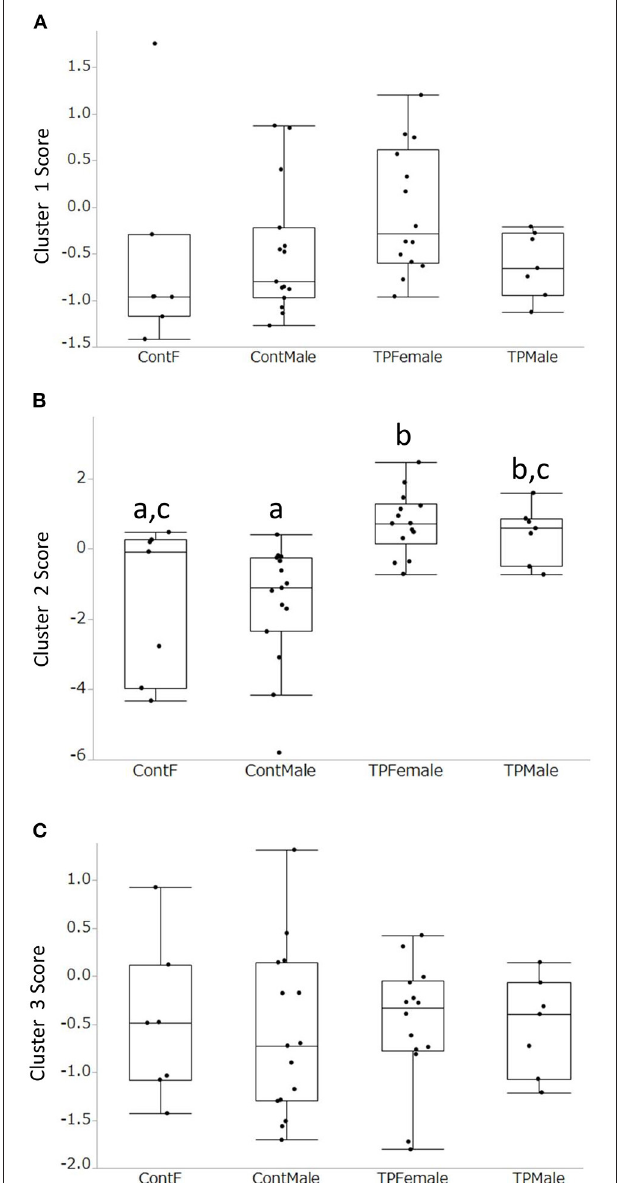
FIGURE 2 | Comparisons of the 3 cluster scores among the 4 groups. There was no sex difference between control male and control female. (A) : Cluster 1, Frequency modulation; (B) : Cluster 2, Frequency; (C) : Cluster 3, Duration and Slope. In Cluster 2, TP-treated females had higher scores than control males and control females (B) . TP-treated males had higher scores than control males. Different alphabet letters (e.g., a and b) mean that there was a statistically significant difference between the two groups obtained using the Kruskal-Wallis test followed by the Steel-Dwass test.